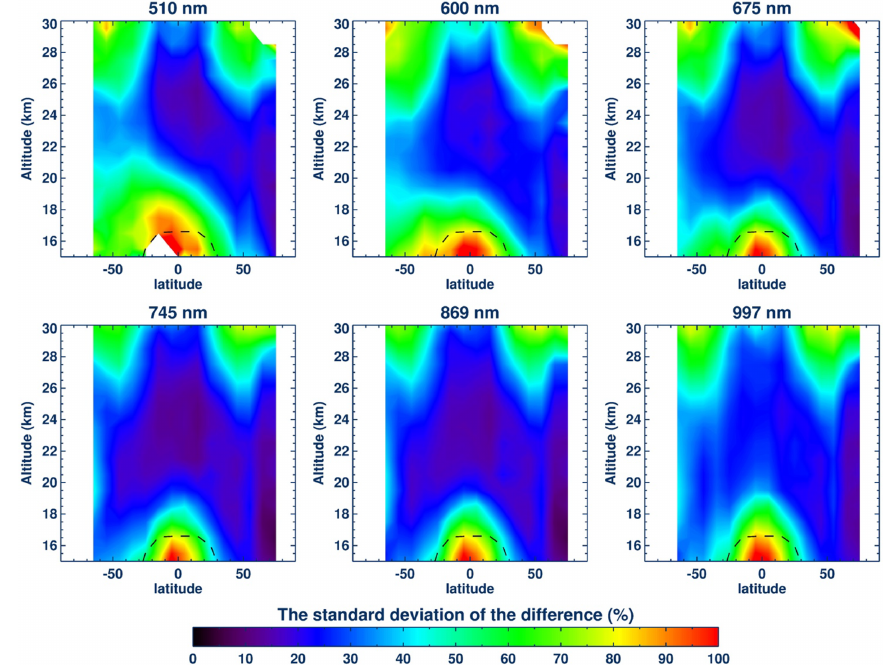
Figure 8. Same as Fig. 7 but for the 1 − σ standard deviation or spread of difference between OMPS LP and SAGE III.